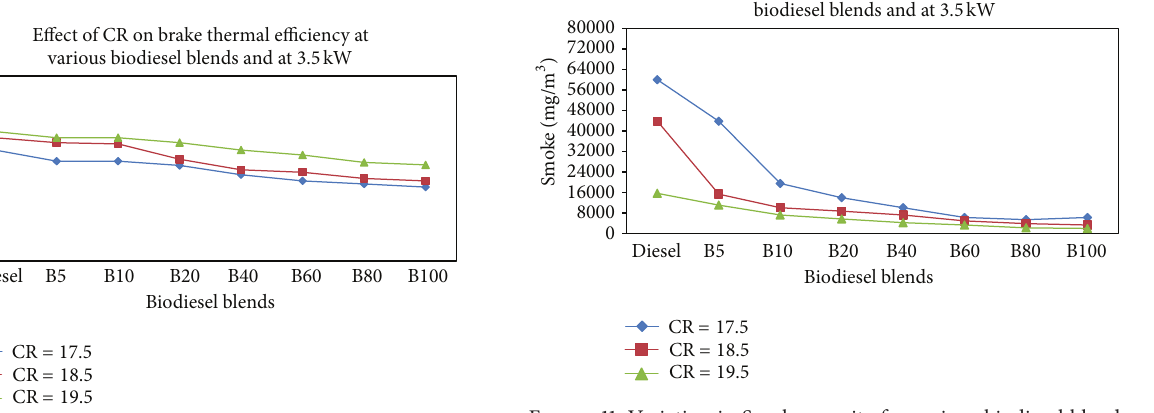
Figure 9: Variation in BTE for various blends at compression ratios 17.5, 18.5, and 19.5.